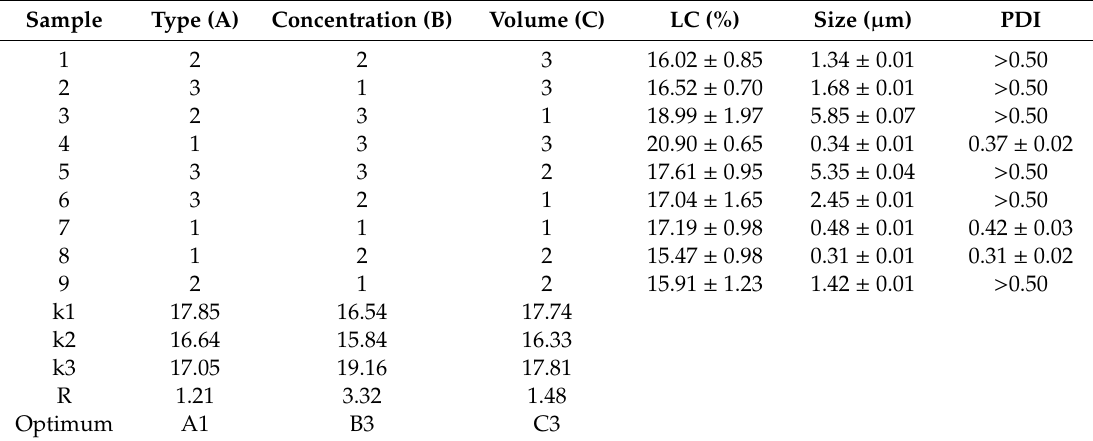
Table 2. The optimization of emulsifiers by orthogonal experiment (L 9 3 4